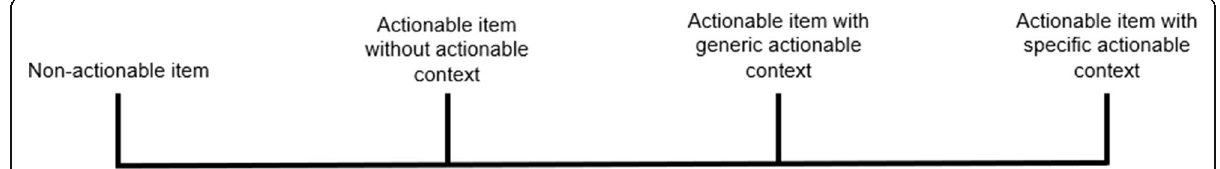
Fig. 3 Actionability spectrum in Likert scale form. The nodes identified in the spectrum range from Non-actionable item (minimum level of actionability) to Actionable item with specific actionable context (maximum level of